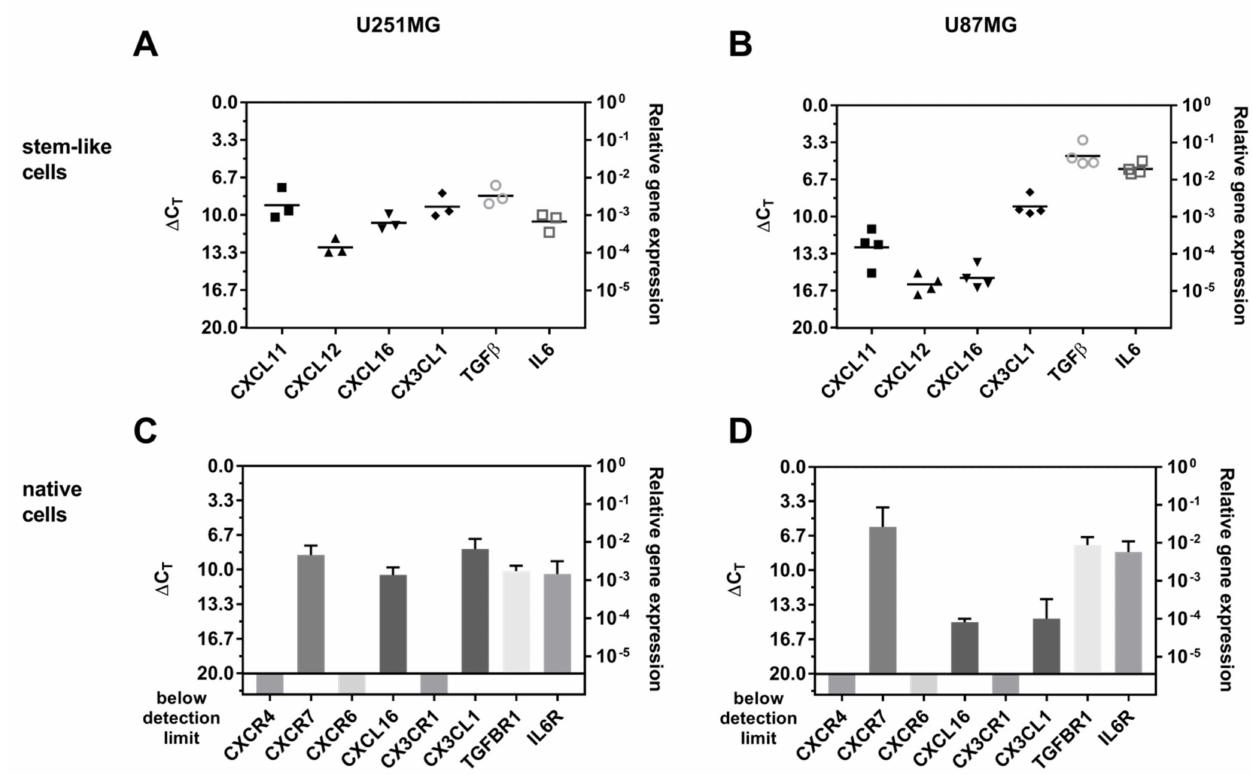
Figure 6. qPCR analysis of the mRNA expression of cytokines and chemokines together with their corresponding receptors in stem-like versus native GBM cells. Gene expression of different cytokine and chemokine ligands in stem-like ( A ) U251MG ( n = 3) and ( B ) U87MG cells ( n = 4); Corresponding receptor expression of native ( C ) U251MG cells ( n = 3) and ( D ) U87MG cells ( n = 3). The error bars in ( C , D ) correspond to the standard